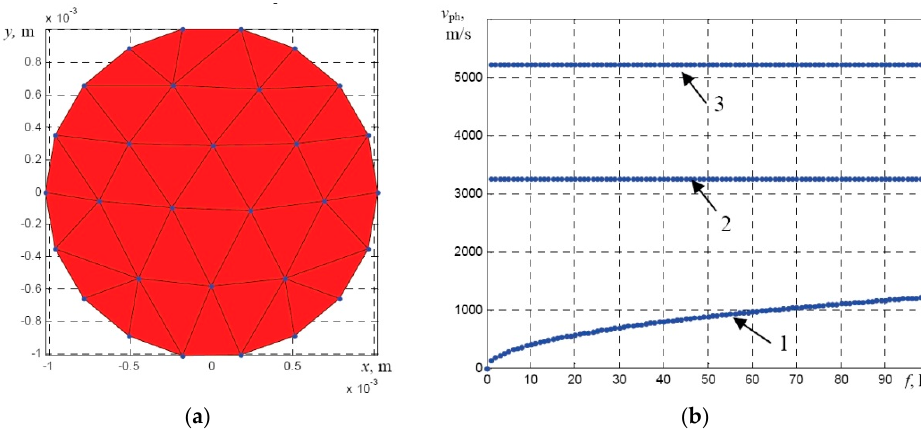
Figure 2. The mesh of the SAFE model of a single wire with diameter of 2.05 mm ( a ) and the dispersion curves of the phase velocity of guided wave modes ( b ): 1—flexural F (1,1) mode; 2—torsional T (0,1) mode; 3—longitudinal L (0,1) mode. Table 1. Material properties between neighboring wires used for the calculation of the dispersion curves.